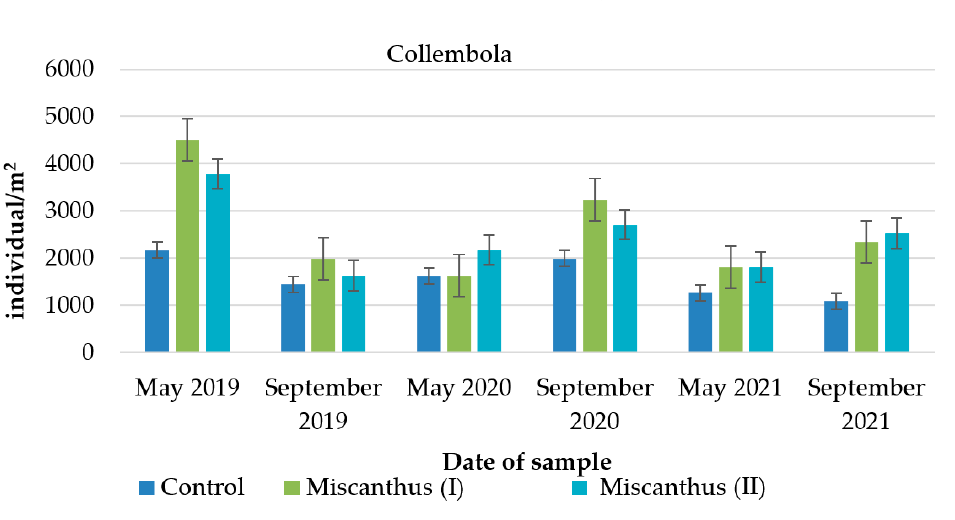
8 of 13 Figure 5. The number of oribatids on the studied soil under the Miscanthus : May 2019– НІР 05 = 225; September 2019– НІР 05 = 146; May 2020– НІР 05 = 130; September 2020– НІР 05 = 192; May 2021–